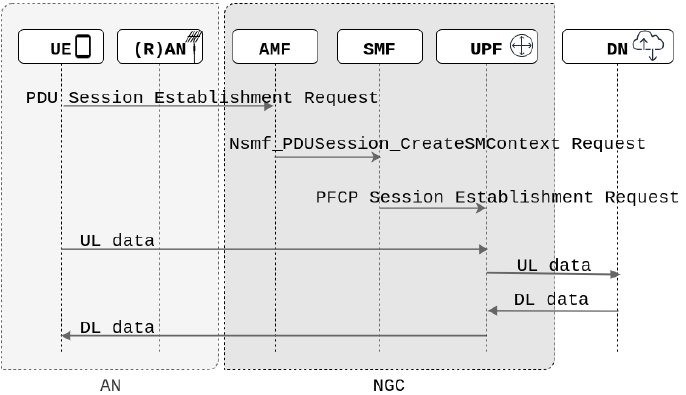
Figure 4. Simplified procedure for requesting session